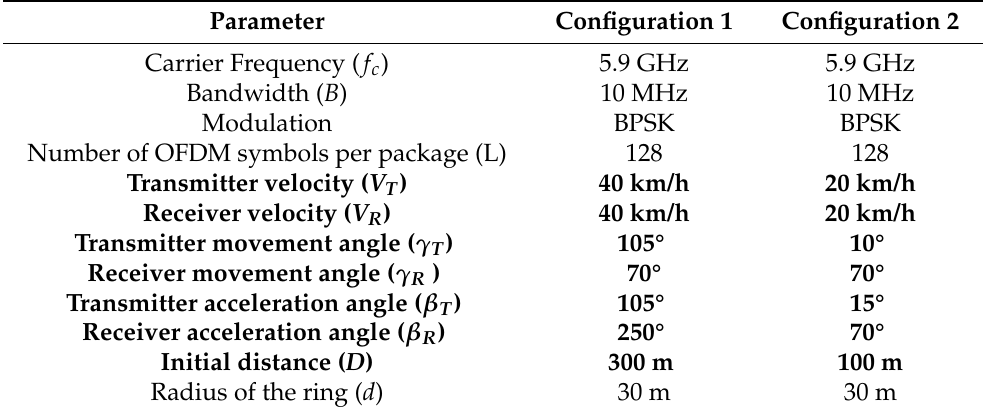
Table 2. Simulation